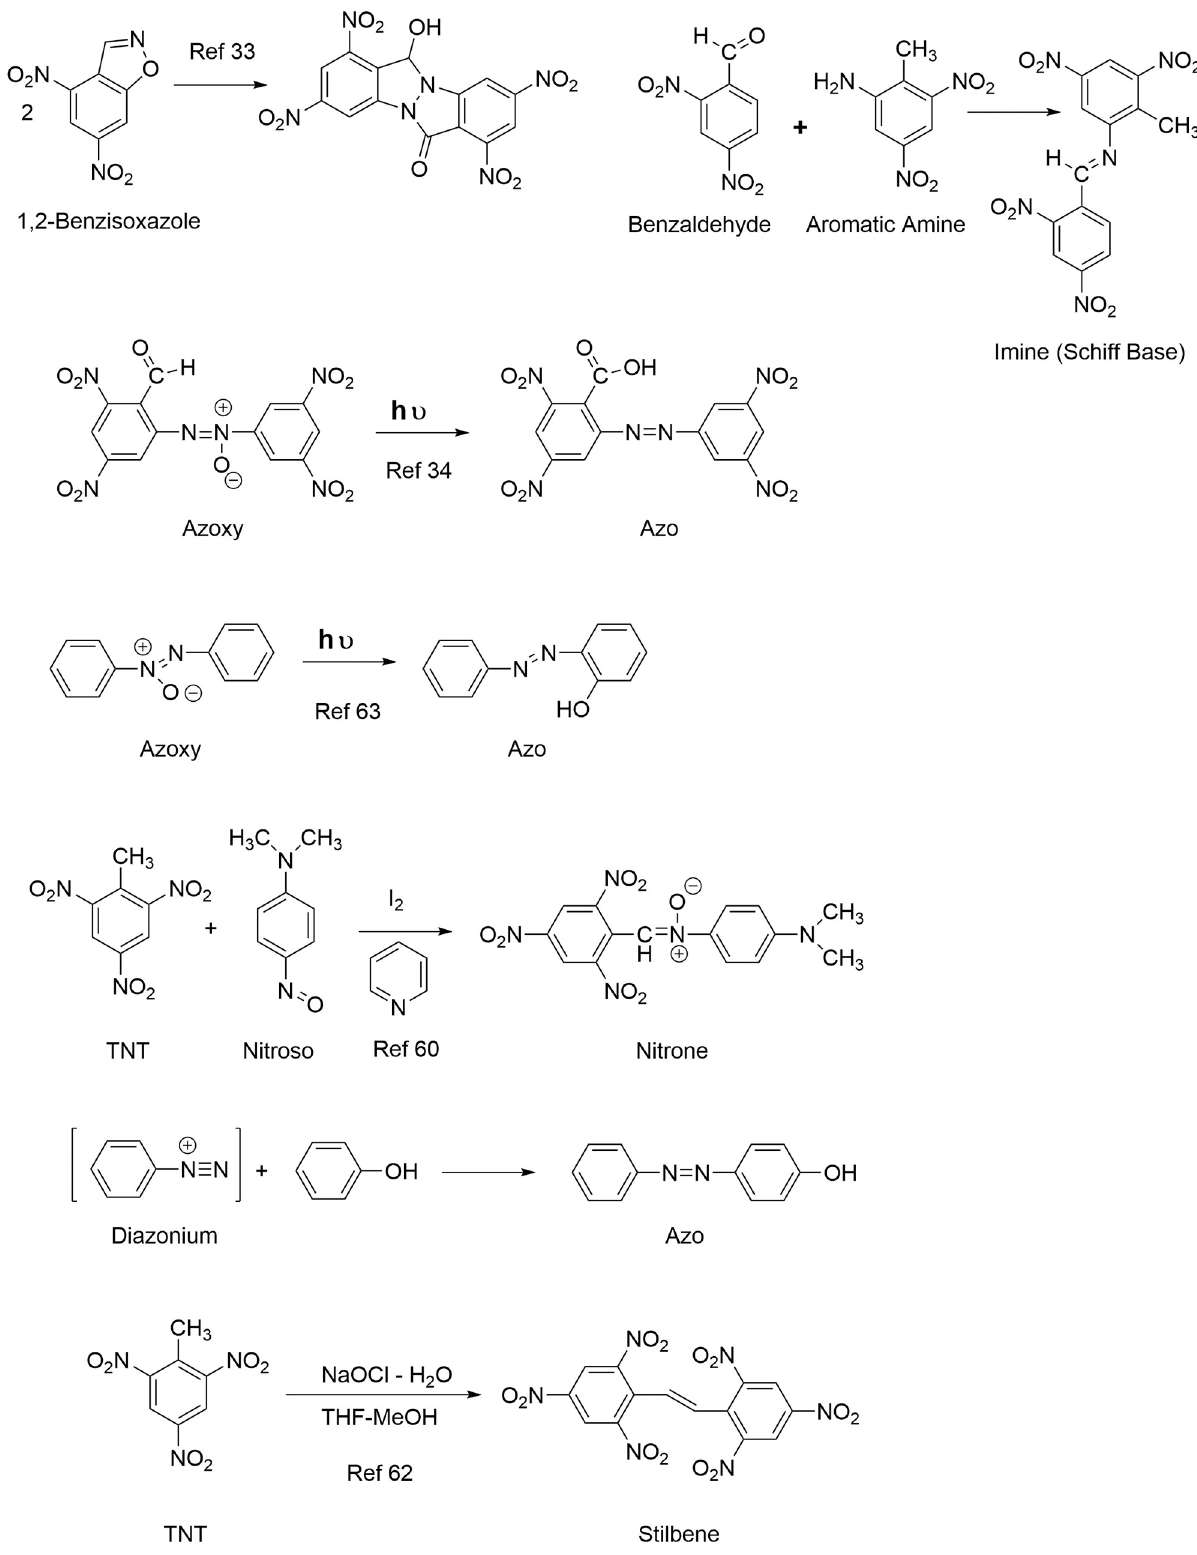
Fig 4. Photochemical transformation reactions of TNT.